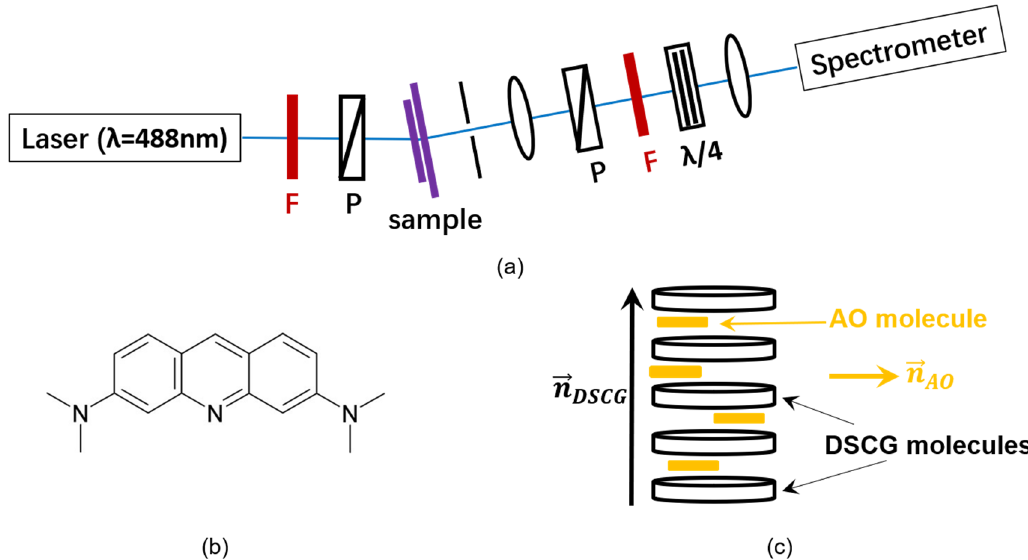
Figure 2. Principles of fluorescence dichroism. ( a ) Experimental setup. F: color filters; P: linear polarizers; λ /4: quarter wave plate. Rotating the polarizers yields the maximum and the minimum fluorescence intensity. ( b ) Chemical structure of an acridine orange (AO) molecule. ( c ) Interaction of the dye with columnar DSCG aggregates.